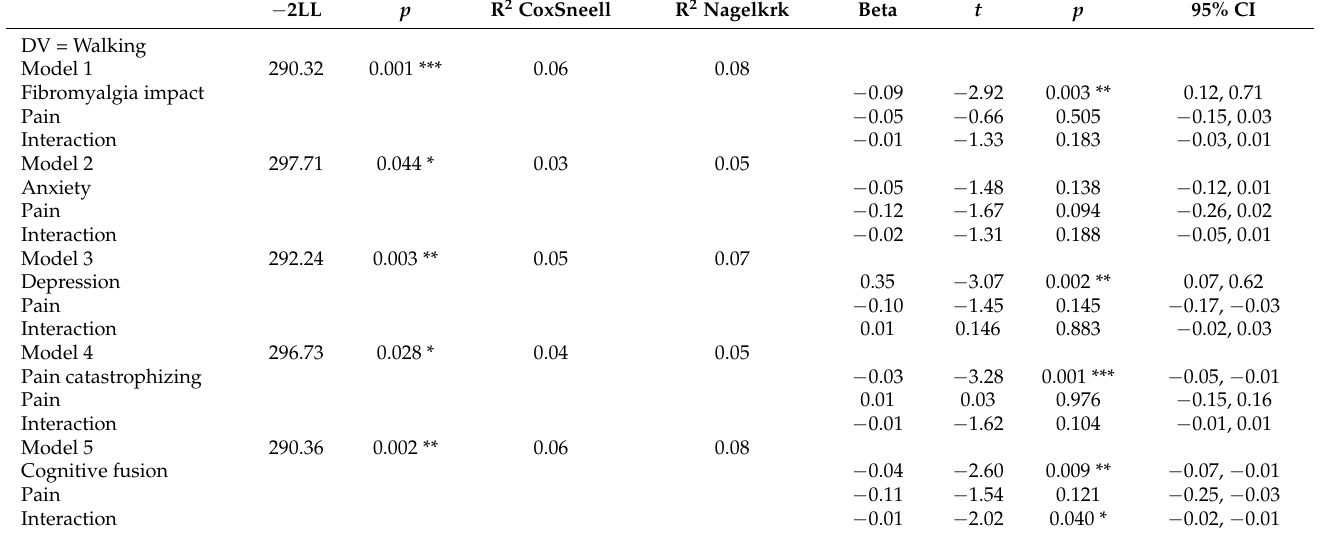
Table 2. Prediction of adherence to walking from pain severity, study predictors (fibromyalgia impact, anxiety, depression, catastrophizing, and cognitive fusion), and their interaction (moderation analysis). − 2LL p R 2 CoxSneell R 2 Nagelkrk Beta t p 95% CI DV = Walking Model 1 290.32 0.001 *** 0.06 0.08 Fibromyalgia impact − 0.09 − 2.92 0.003 ** 0.12, 0.71 Pain − 0.05 − 0.66 0.505 − 0.15, 0.03 Interaction − 0.01 − 1.33 0.183 − 0.03, 0.01 Model 2 297.71 0.044 * 0.03 0.05 Anxiety − 0.05, 0.01 Model 3 292.24 0.003 ** 0.05 0.07 Depression 0.35 − 3.07 0.002 ** 0.07, 0.62 Pain − 0.10 − 1.45 0.145 − 0.17, − 0.03 Interaction 0.01 0.146 0.883 − 0.02, 0.03 Model 4 296.73 0.028 * 0.04 0.05 Pain catastrophizing − 0.03 − 3.28 0.001 *** 0.01 0.03 0.976 − 0.15, 0.16 Interaction − 0.01 − 1.62 0.104 − 0.01, 0.01 Model 5 290.36 0.002 ** 0.06 0.08 Cognitive fusion − 0.04 − 2.60 0.009 ** − 0.07, − 0.01 Pain − 0.11 − 1.54 0.121 − 0.25, − 0.03 Interaction